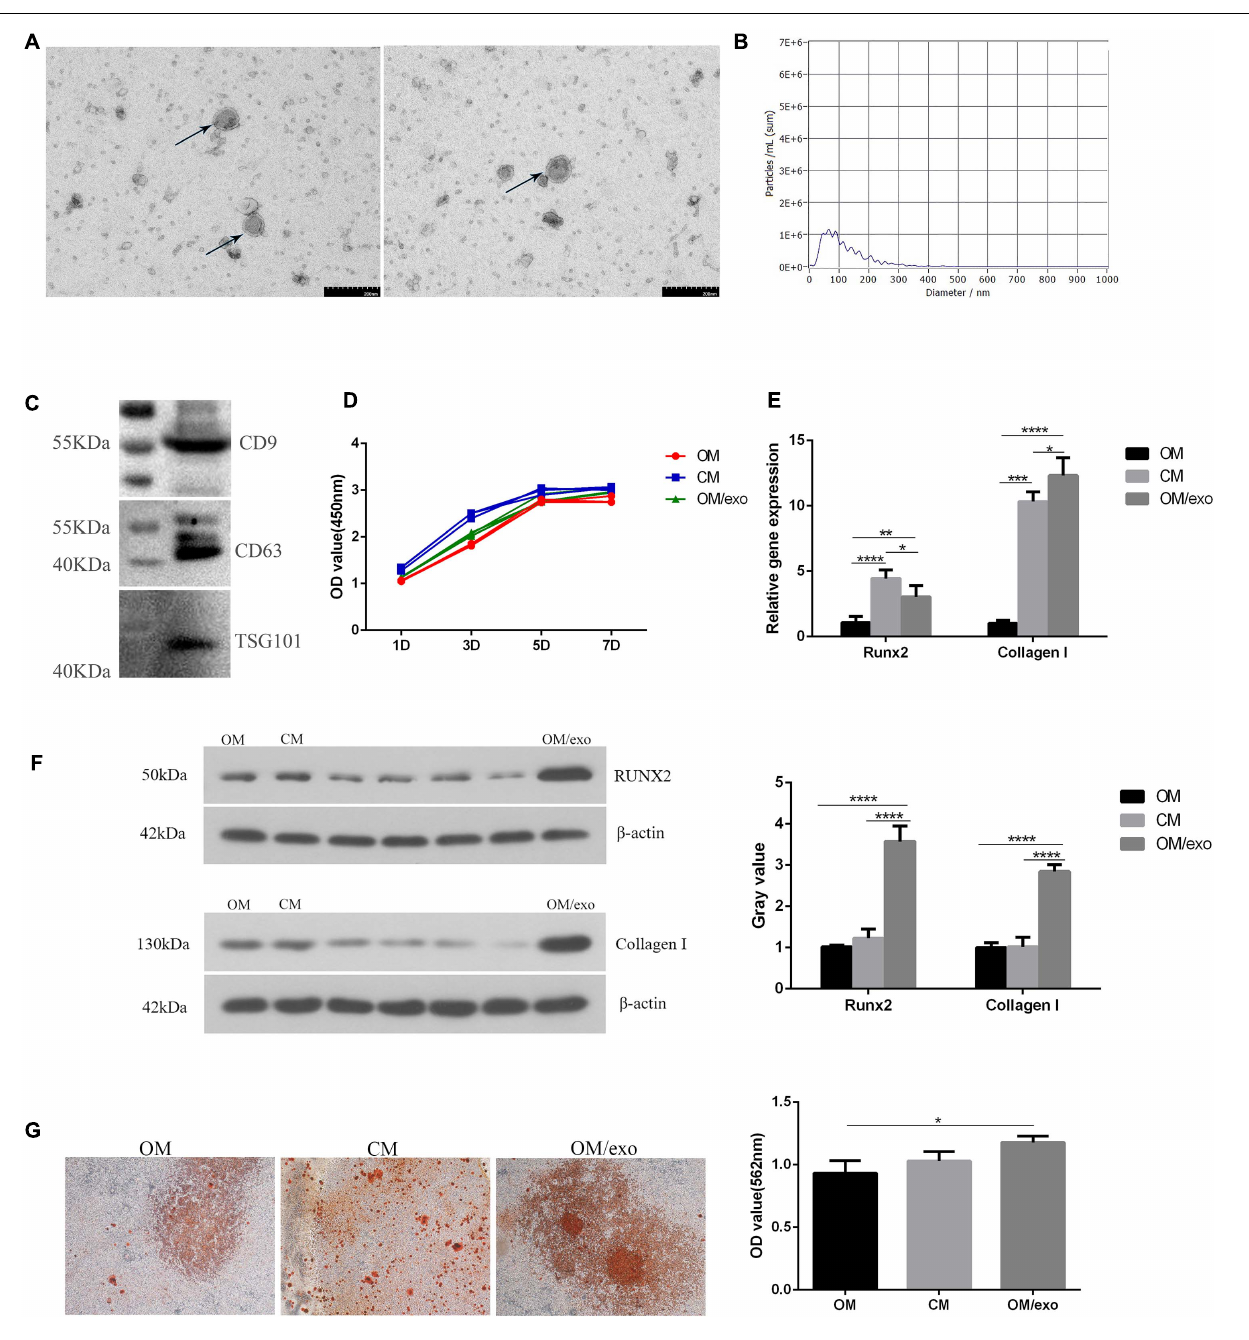
FIGURE 3 | Identification of exosomes and their effects on osteogenic differentiation of MC3T3-E1 cells. (A) TEM showed the shape of exosomes; (B) NTA showed the diameter of exosomes; (C) Western blot showed the expression of exosomes surface marker protein CD9, CD63, and TSG101; (D) CCK-8 showed cell proliferation; (E) qRT-PCR showed the expression of osteogenic related genes Runx2, Collagen I in MC3T3-E1 cells; (F) Western blot showed the expression of osteogenic related genes Runx2 and Collagen I in MC3T3-E1; (G) The mineralization of MC3T3-E1 cells was detected by alizarin red. [OM, osteogenic induction medium; CM (osteogenic induction medium + RAW264.7 cell culture medium), OM/exo: CM with RAW264.7 cell-derived exosomes (* p < 0.05; ** p < 0.01; *** p < 0.001; **** p <